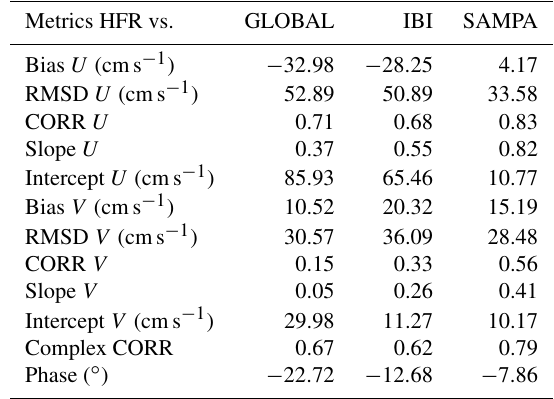
Table 3. Skill metrics derived from the 1-year (2017) validation of sea surface currents estimated by three operational forecasting sys- tems against HFR-derived observations at the midpoint of the se- lected transect in the Strait of Gibraltar (Fig.